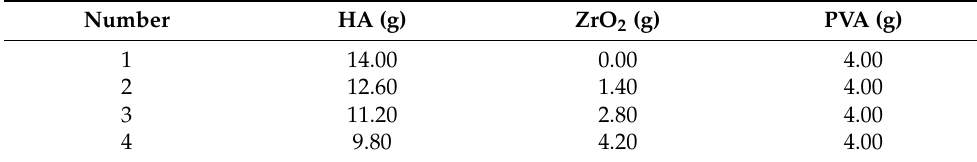
Table 1. Composition of composite slurry with different